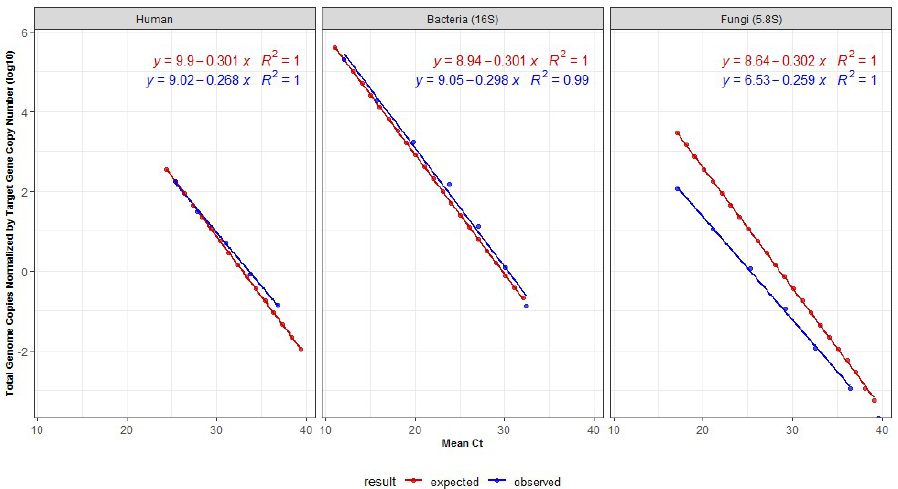
Figure 1. Standard DNA dilution curves for human, bacteria (V1-16S) and fungi (5.8S) qPCR, showing expected (red) and observed (blue) Ct-values considering the genome size and target copy number of the bacteria and fungi present in the mock community. Calculations do not consider the variable ploidy observed in many fungi species. Values used for plotting are shown in Table 1. In the equation, y denotes the genome copy number while x denotes the mean Ct value.